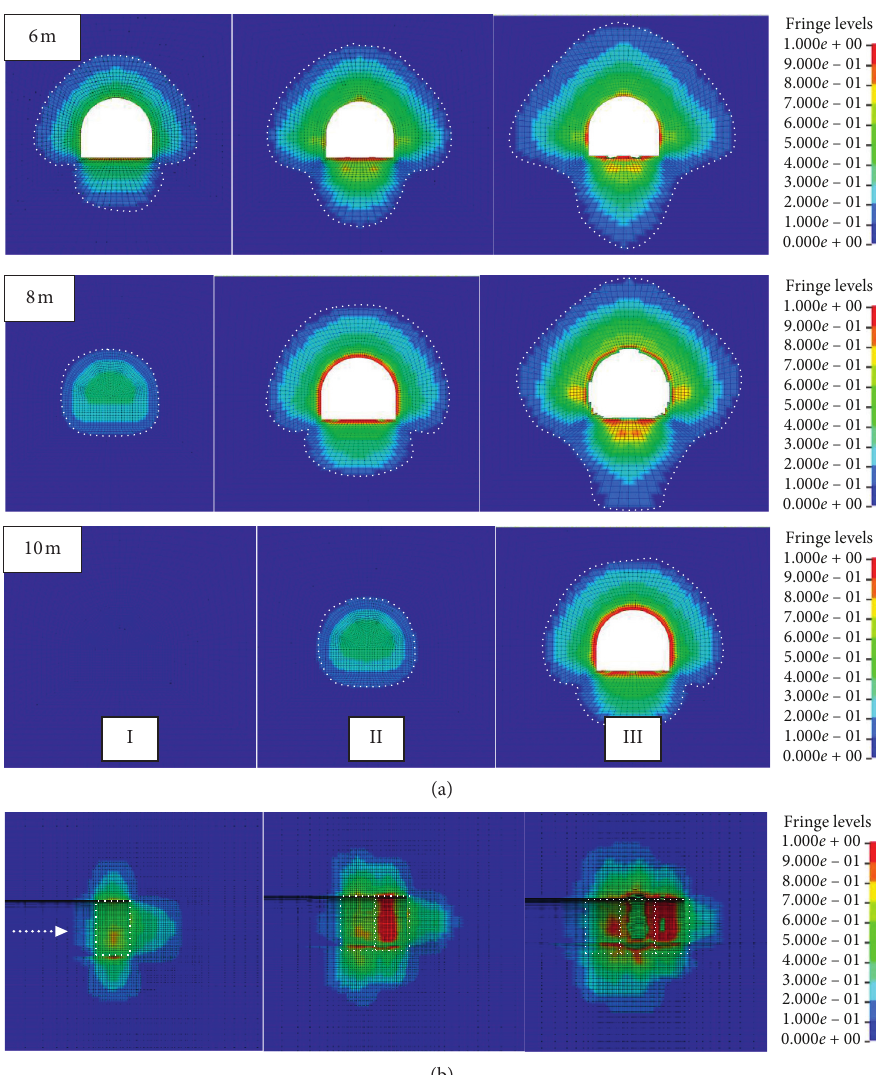
Figure 11: Distributions of the surrounding rock damage. (a) Circumferential damage. (b) Striking